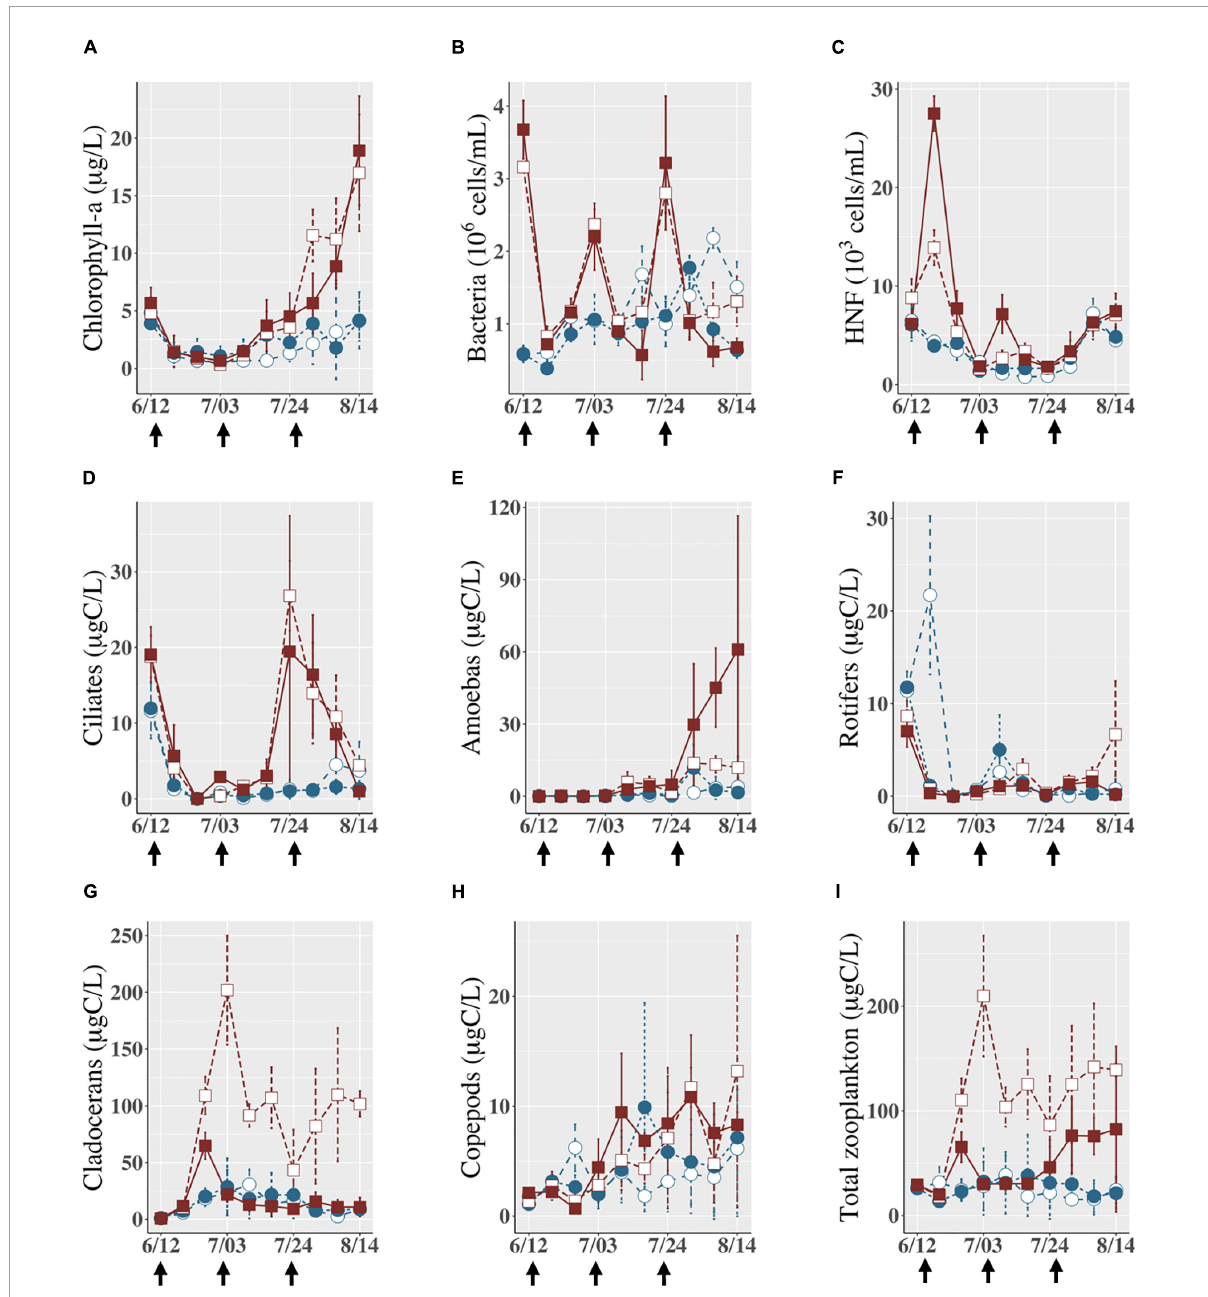
FIGURE3 Abundances of (A) chlorophyll a ( < 100 µ m), (B) bacteria, (C) HNF, and biomasses of (D) ciliates, (E) amoebas, (F) rotifers, (G) cladocerans, (H) copepods, and (I) sum of this zooplankton during the experiment. White squares indicate the LA treatment (unshaded, with leaf homogenate), brown squares indicate the DA treatment (shaded, with leaf homogenate), white circles indicate the LB treatment (unshaded, without leaf homogenate), and blue circles indicate the DB treatment (shaded, without leaf homogenate). Vertical bars on each data point indicate ± SD on the mean (3 replicates). The black arrows at the bottom of the graph are the dates when leaf homogenate was added to LA and DA treatments.